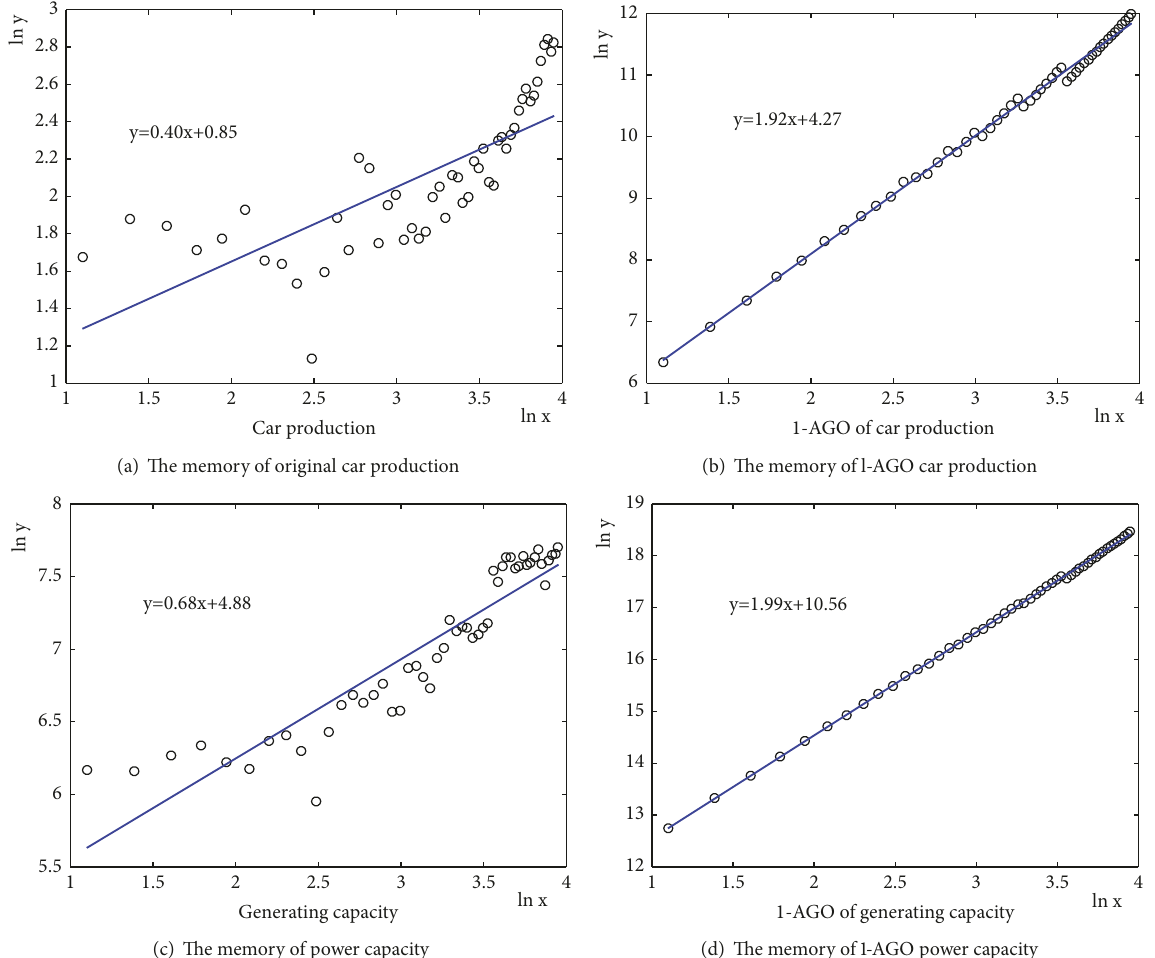
Figure 6: The memory of original value and one-order accumulation value for two